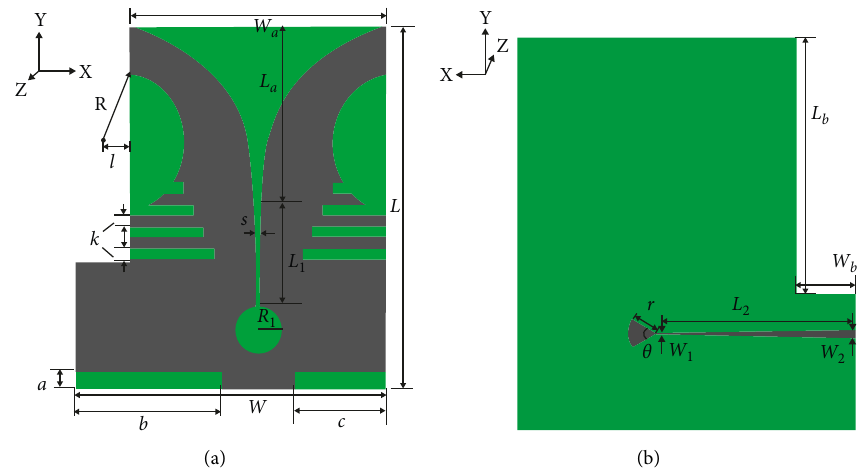
Figure 2: Structure of improved Vivaldi antenna: (a) front; (b) back.